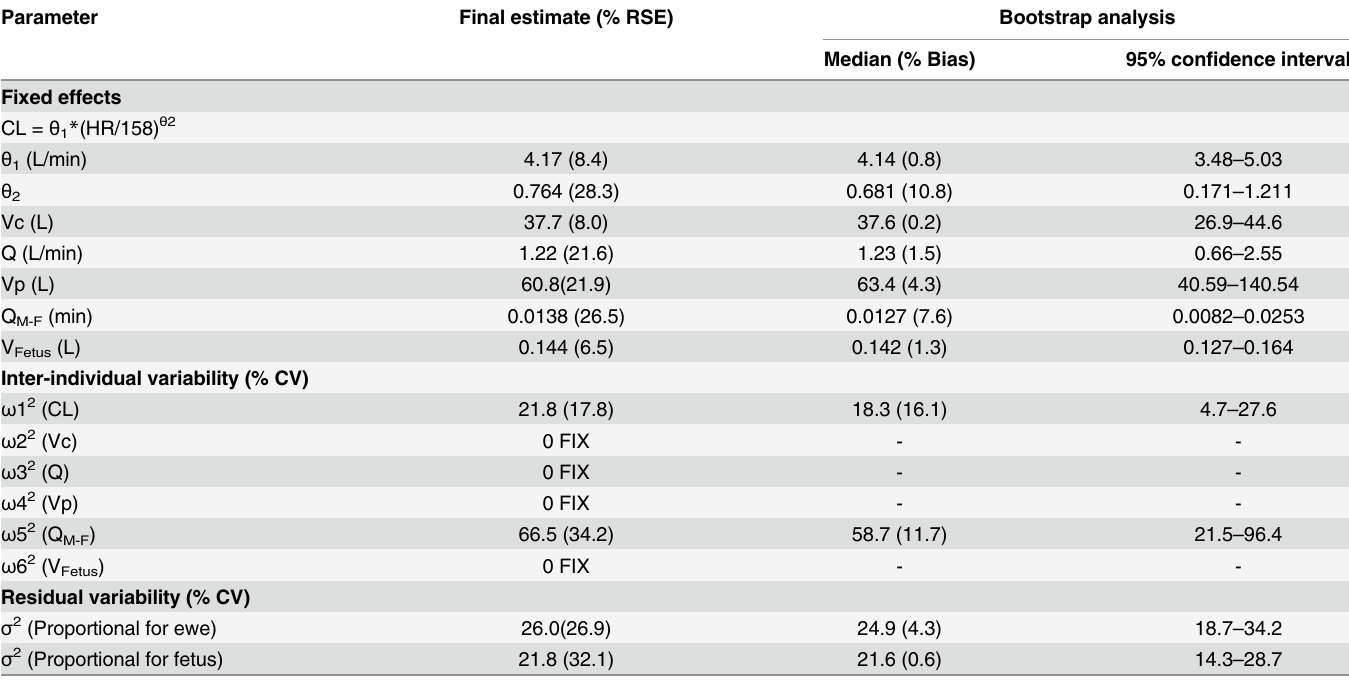
Table 2. Population pharmacokinetic parameter estimates of propofol in mid gestational maternal-fetal